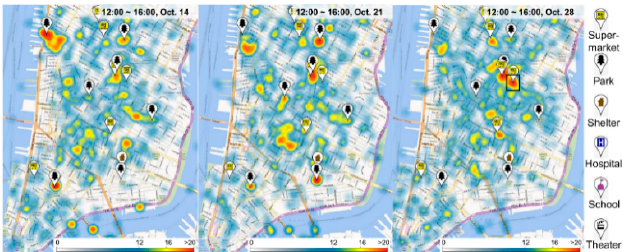
Figure 16. Heatmap views of spatial tweet distribution during a hurricane disaster [50].